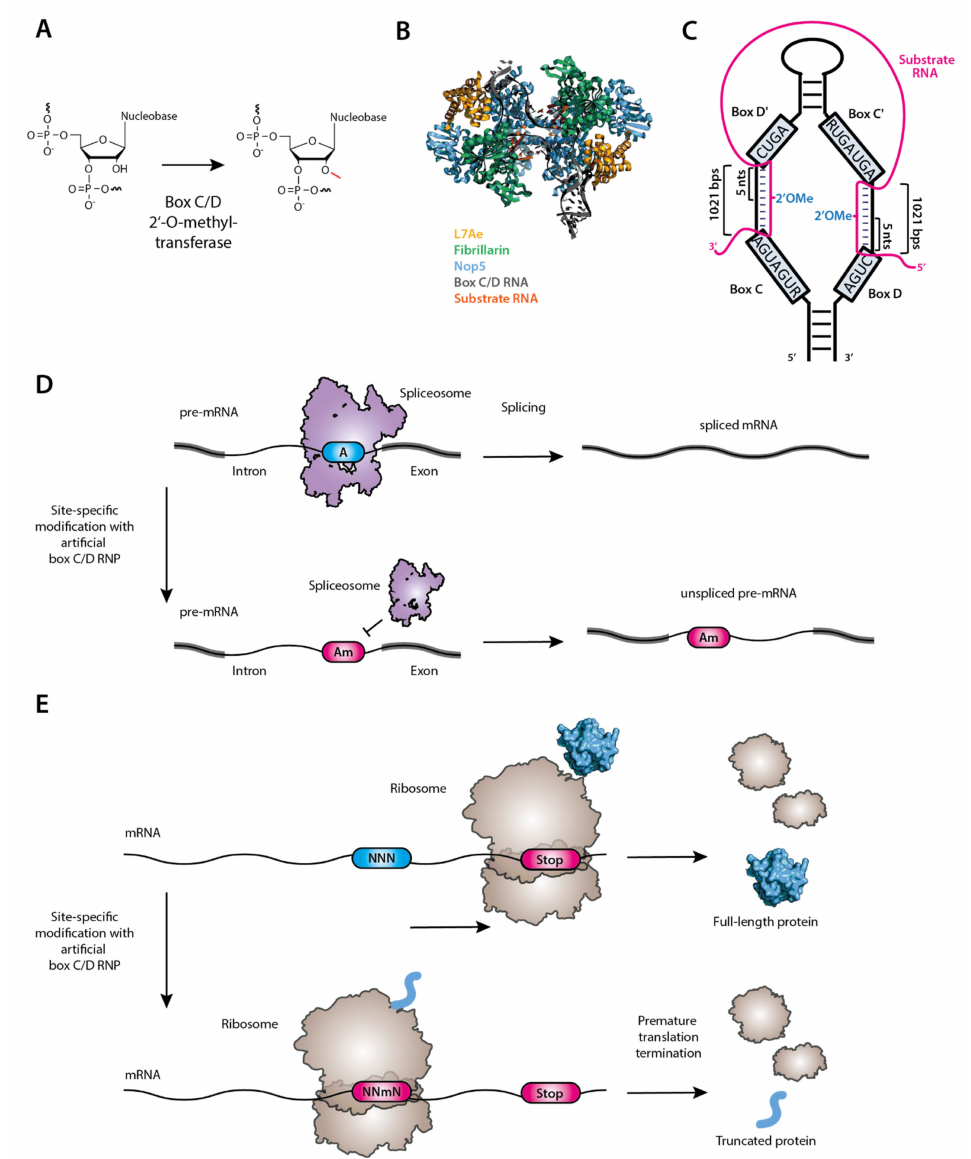
Figure 4. ( A ) Methyltransferase (standalone or box C/D RNP complex) catalyzes RNA 2 (cid:48) - O-methylation. ( B ) Crystal Structure of substrate-bound box C/D RNP (PDB: 5GIN [161]). ( C ) Schematic description of the secondary structure of the box C/D snoRNA (black). Substrate RNA is shown in magenta. ( D ) Site-specific, box C/D-directed methylation of the branchpoint adenosine (blue box) to yield Am (magenta box) results in inhibition of splicing of this intron. ( E ) Site- specific methylation of a central nucleotide within a sense codon results in premature translation termination, which can be used to inhibit the translation of nonfunctional, disease-relevant